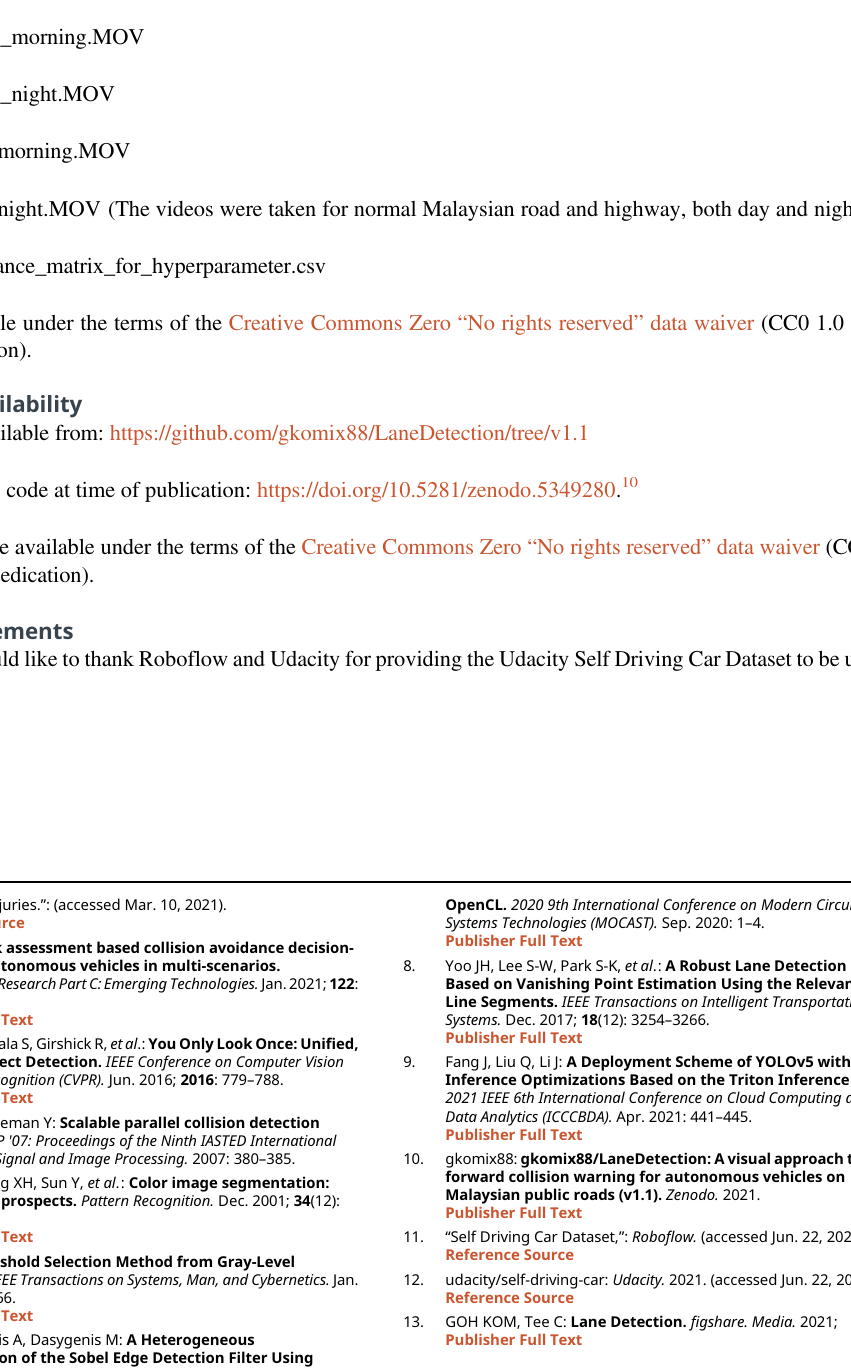
Figshare: Lane Detection. https://doi.org/10.6084/m9.figshare.16557102.v2. 13